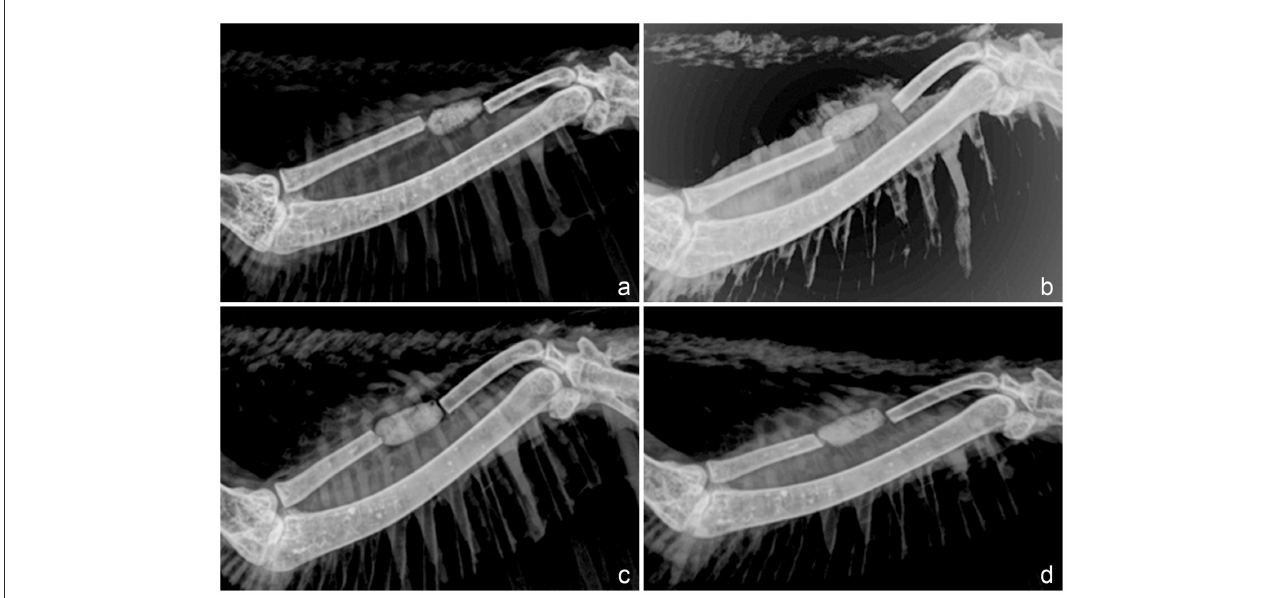
FIGURE2 Mediolateral radiographic views of the antebrachium of chickens immediately after surgery (a, c) and on day 21 postoperative (b, d) . Group 1 (a, b) corresponds to the bone defect filled with bone cement, and Group 2 corresponds to the bone defect filled with cefazolin powder-loaded bone cement (c, d) . Observe in both groups the bone cement as a radiopaque structure occupying the bone defect. Note the displacement of the bone cement on day 21 postoperative in Group 1 (b) .